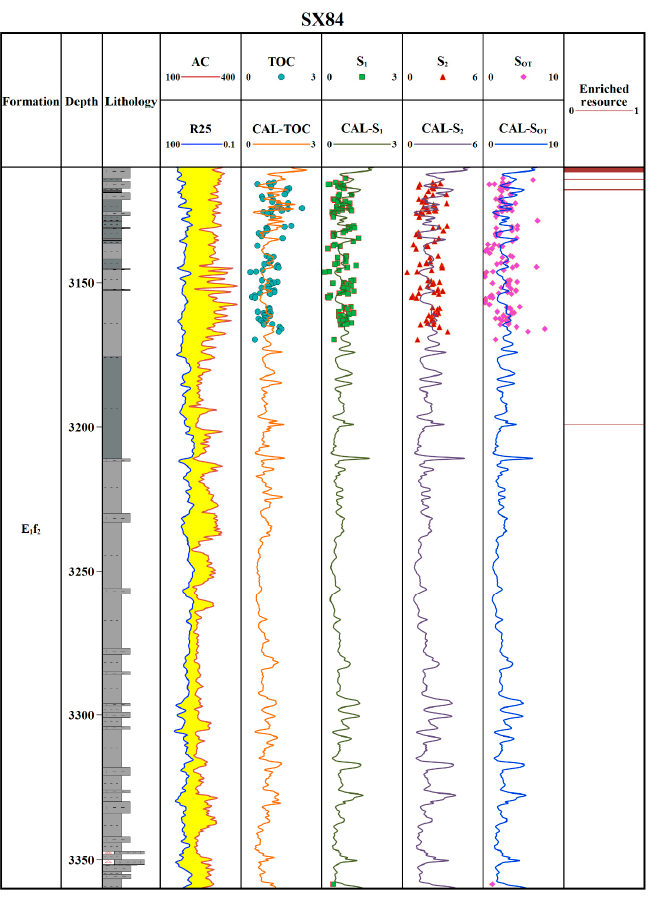
Figure 8. Results calculated using the Δ log R method of Well SX84.